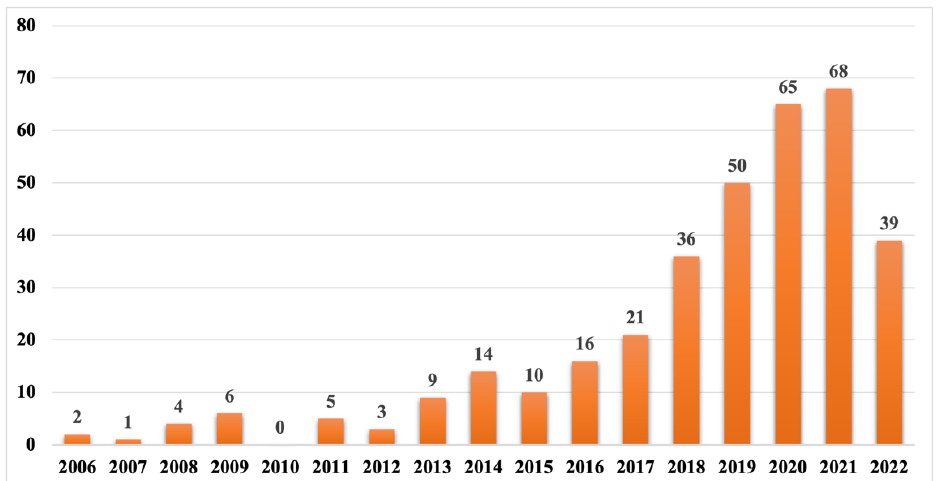
Figure 2. The chronological distribution of the number of articles published from 2006 – 2022.